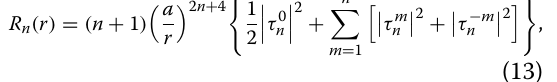
Fig. 8 Real (left) and imaginary (right) parts of the radial component of the M 2 oceanic tidal magnetic field for SH degrees n altitude from CM6 (top) and G&O